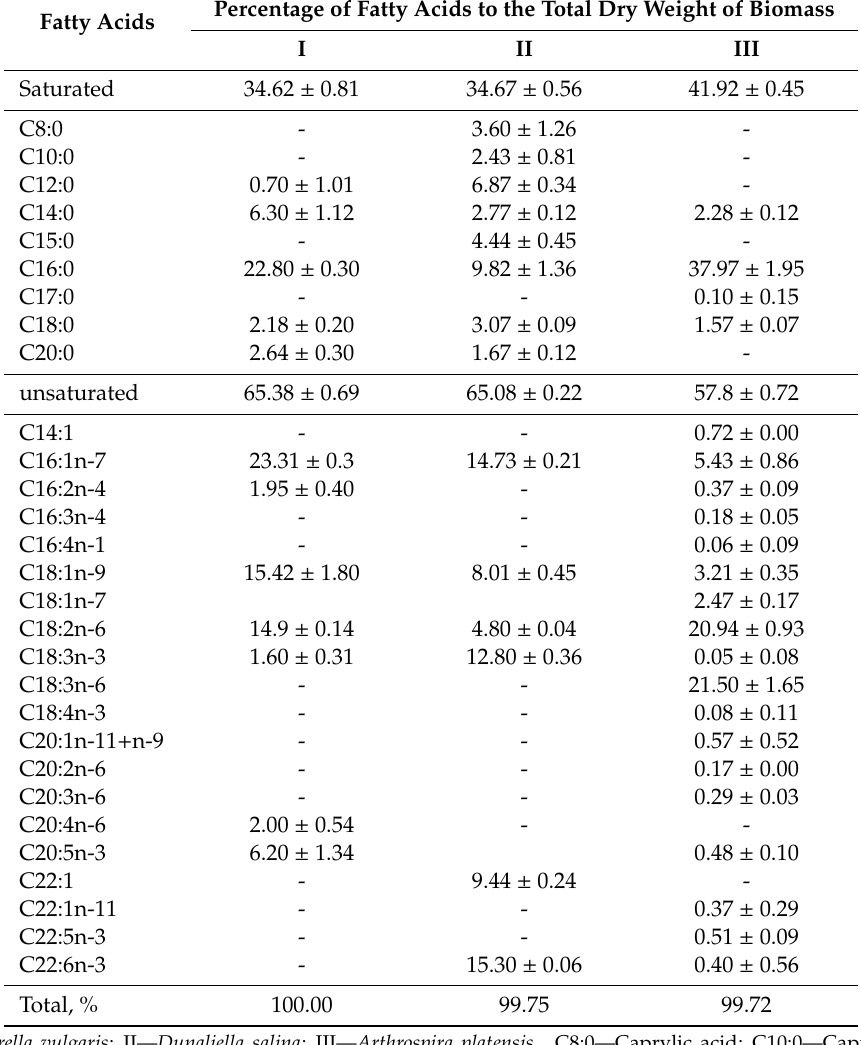
Table 3. Fatty acid composition of microalgae biomass. Fatty